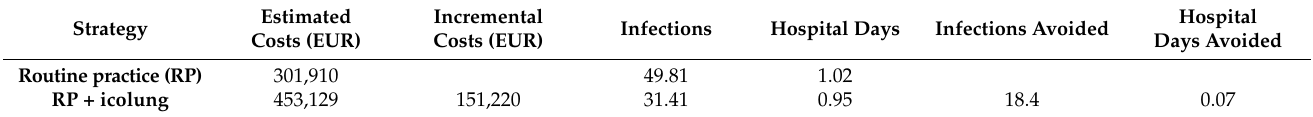
Table 2. Base case analysis results: costs and outcomes per 1000 patients.